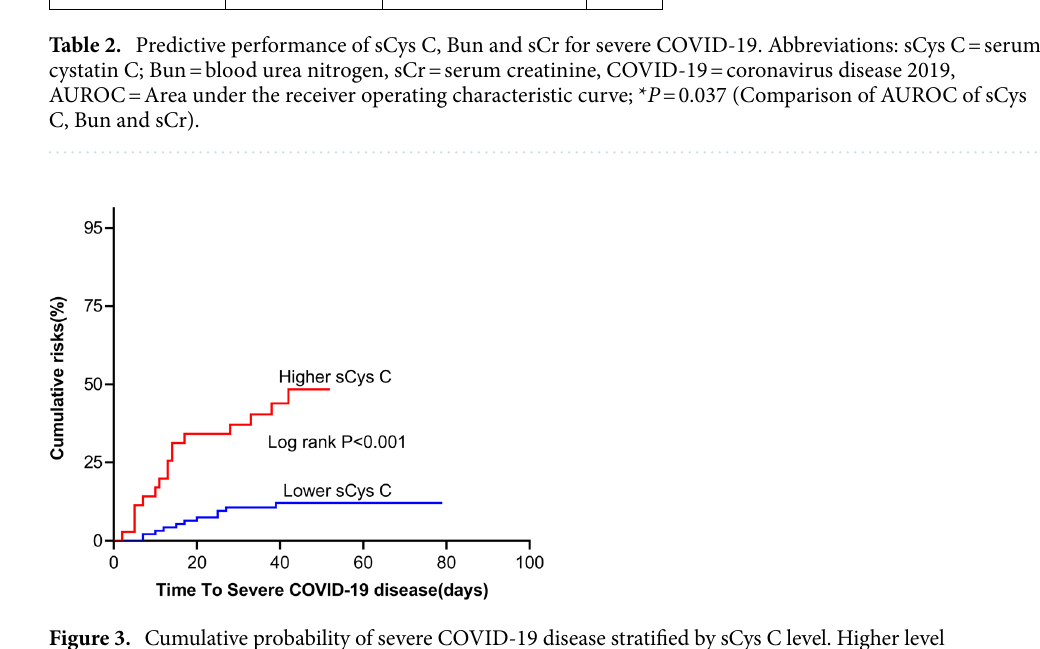
Figure 3. Cumulative probability of severe COVID-19 disease stratified by sCys C level. Higher level means > 1.245 (mg/L); Lower level level means < 1.245 (mg/L). Abbreviations: COVID-19 = coronavirus disease 2019; sCys C = serum cystatin C.